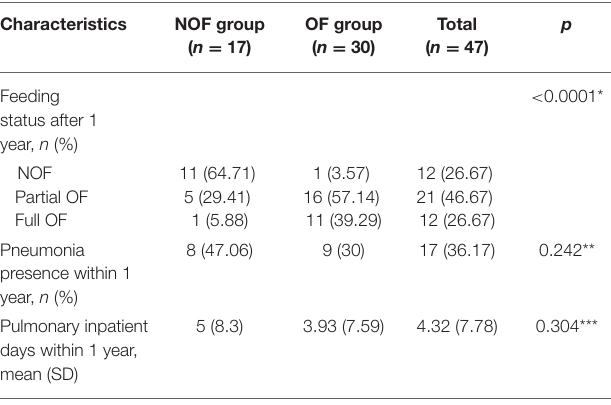
TABLE 2 | Outcome assessment 1 year after videofluoroscopic swallowing study in each group.